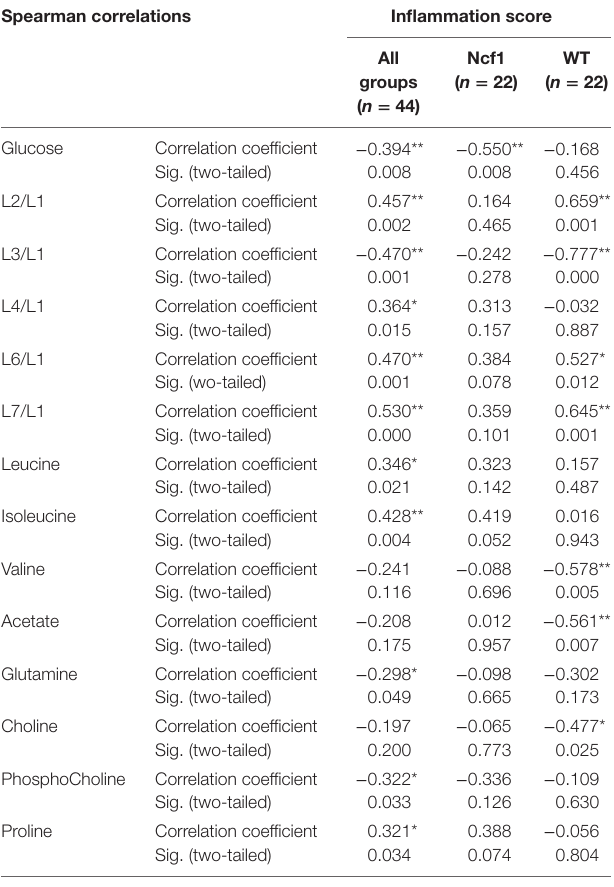
TaBle 3 | Summary of all statistically significant Spearman correlations for inflammation score vs metabolites concentrations considering either all mice